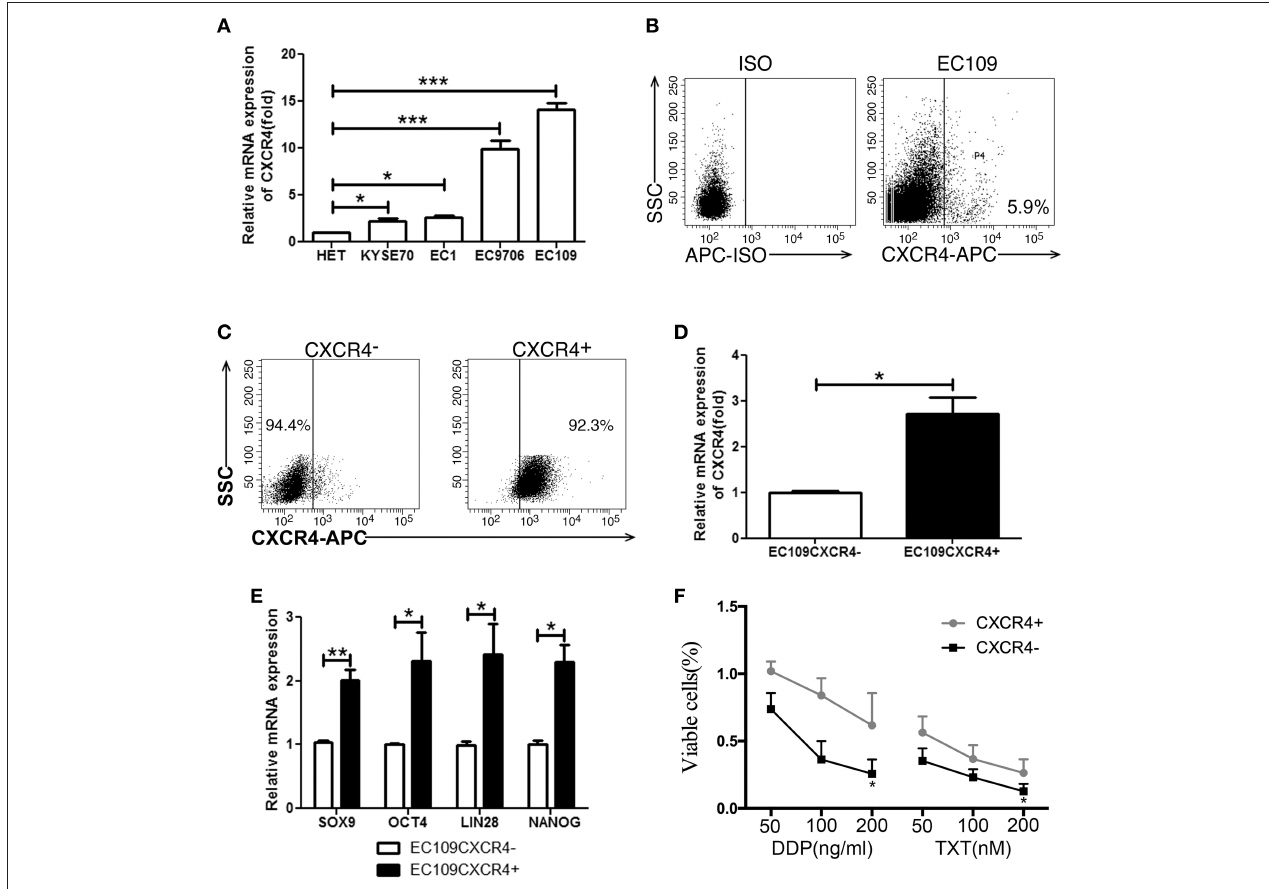
FIGURE 3 | CXCR4 positive cells possessed stem-like properties. (A) The CXCR4 expression was detected by real time PCR in 1 immortalized esophageal cell line (Het-1a) and 4 ESCC cell lines. (B) The expression analysis of CXCR4 was detected by flow cytometry. (C) The purity of sorted EC109 cells with or without CXCR4 expression. (D) The expression analysis of CXCR4 was detected by real time PCR. (E) The expression analysis of stemness-related transcription factors (SOX9, OCT4, LIN28, and NANOG) was detected by real time PCR. (F) Cell survival rate was tested by CCK-8 method. * P < 0.05, ** P < 0.01, and *** P <